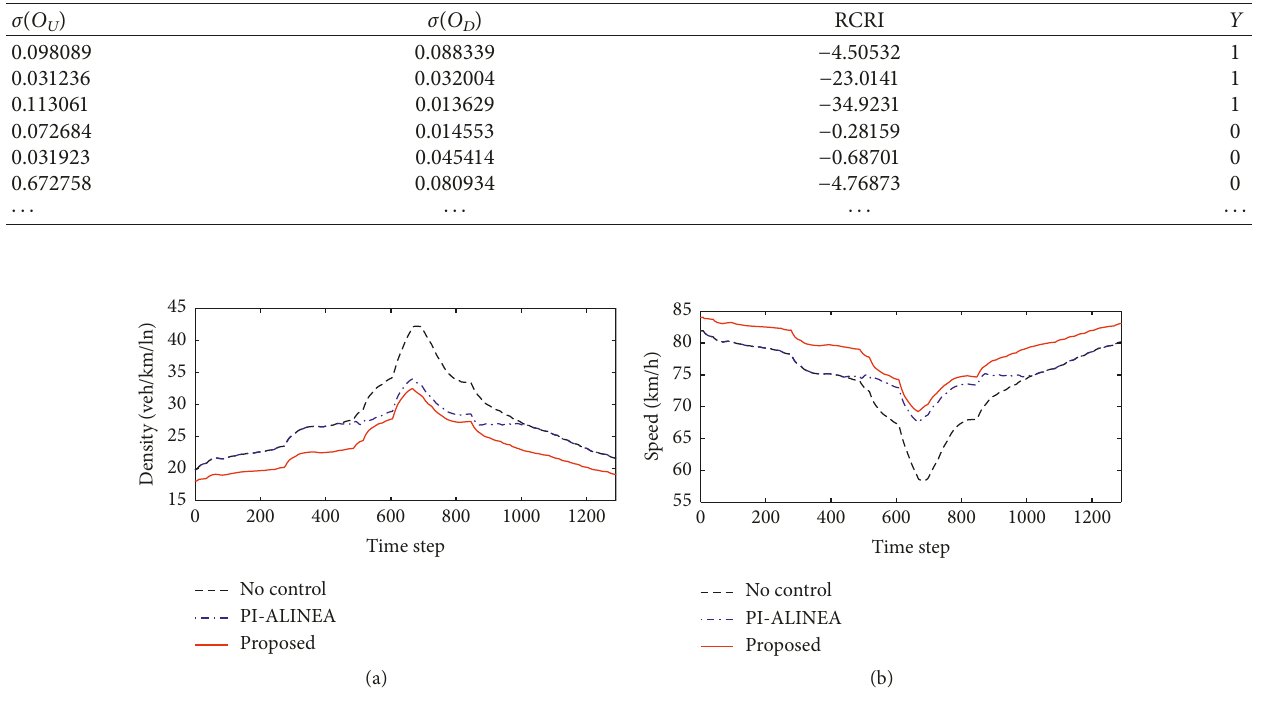
Table 4: Partial traffic data.